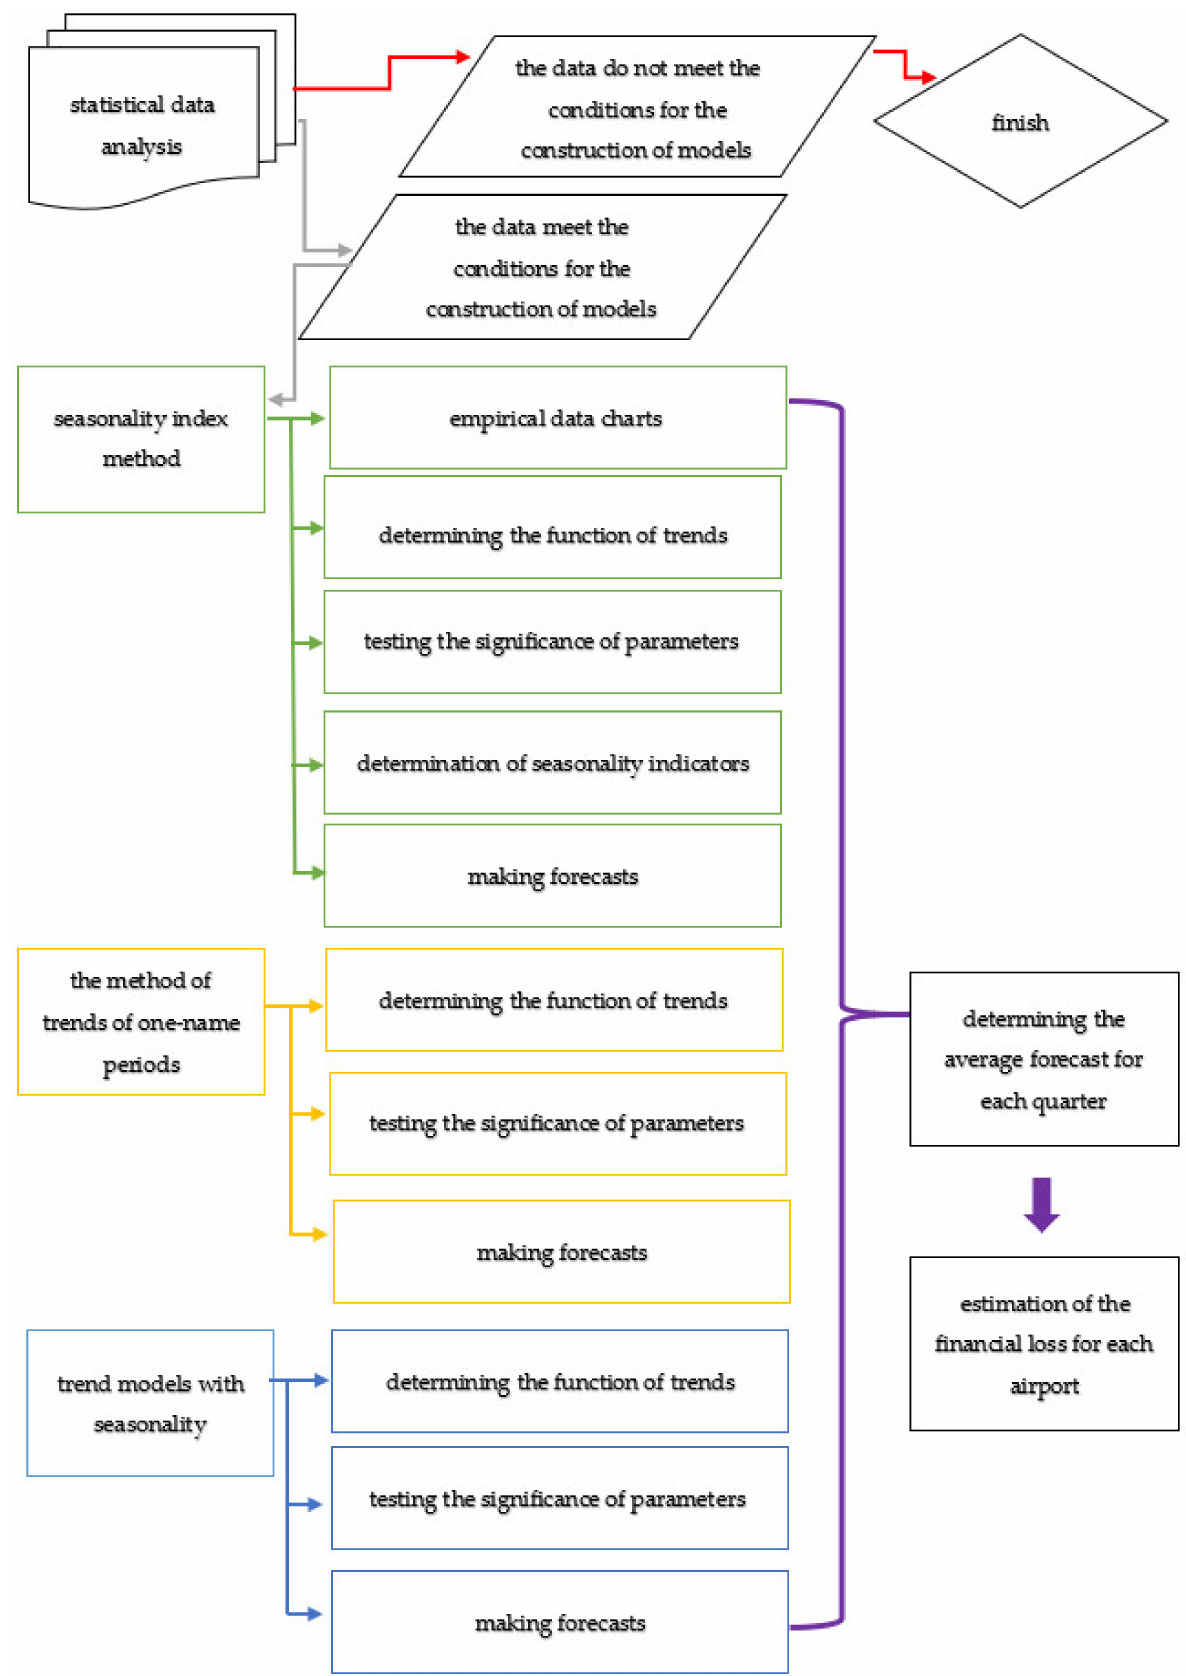
Figure 7. Research methodology